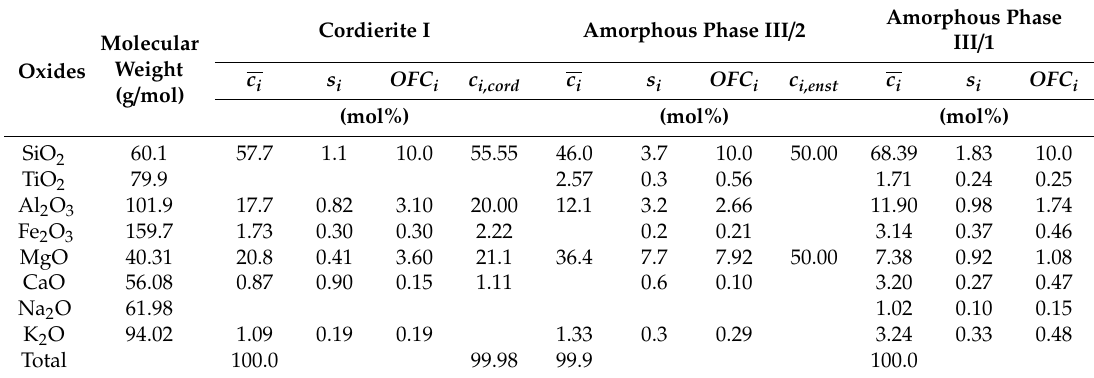
Note: c i , average percentage of elemental oxides calculated from n samples determined by EDS microanalyses and calculated for I, III / 1 and III / 2 phases (Figure 3a); c i,cord and c i,enst , oxide percentage of oxide elements calculated from crystallochemical formulas of cordierite (Ca 0.1 Mg 1.90 Fe(III) 0.40 Al 3.60 Si 5.00 O 18 ) and enstatite (MgSiO 3 ),